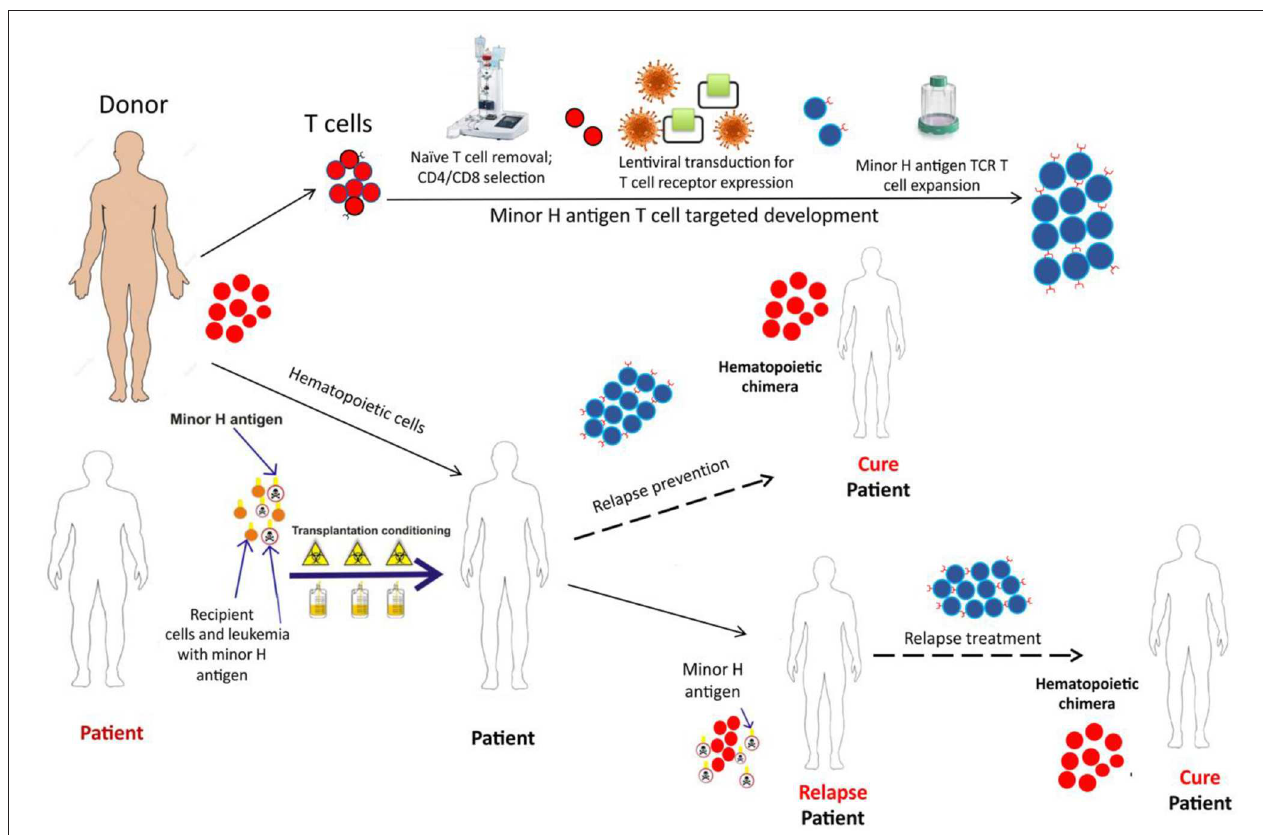
FIGURE 4 | The schematic depicts the development and potential therapeutic use of donor derived minor H antigen targeting T cell therapy. A patient, with the hematopoietically-restricted minor H antigen target, would undergo allogeneic HCT. The donor, lacking the minor H target, would donate hematopoietic cells for the HCT graft and T cells for the immunotherapy product. The T cells would undergo depletion of the naïve T cell fraction (to reduce GVHD risk) and then undergo modification using a lentiviral construct containing a potent TCR targeting the minor H antigen of interest. Following this modification, the cell product would be expanded to develop a therapeutically active cell dose which could be infused soon after the HCT as a relapse prevention strategy or following relapse detection to treat post-HCT